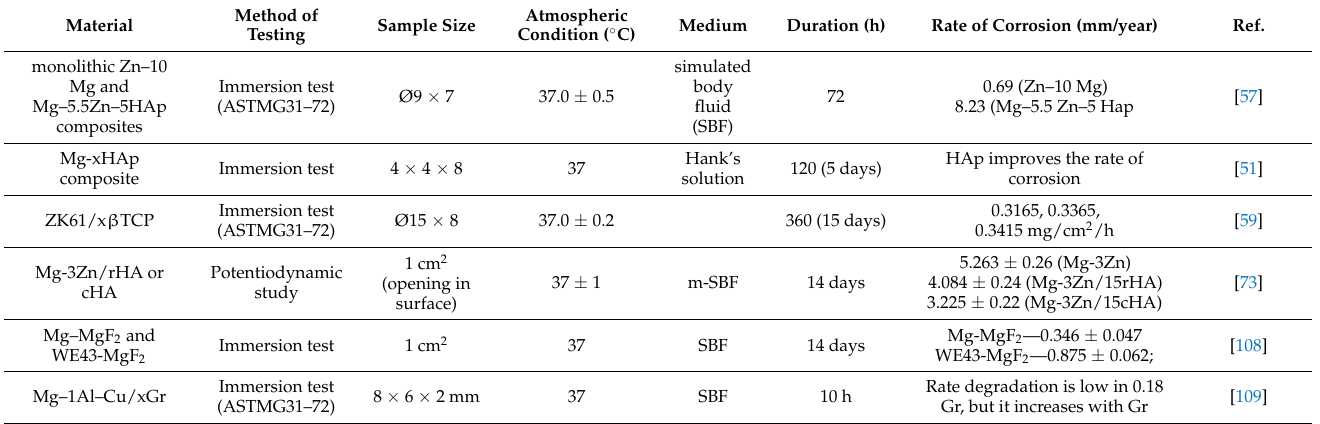
Table 3. Corrosion behavior of Mg composites.